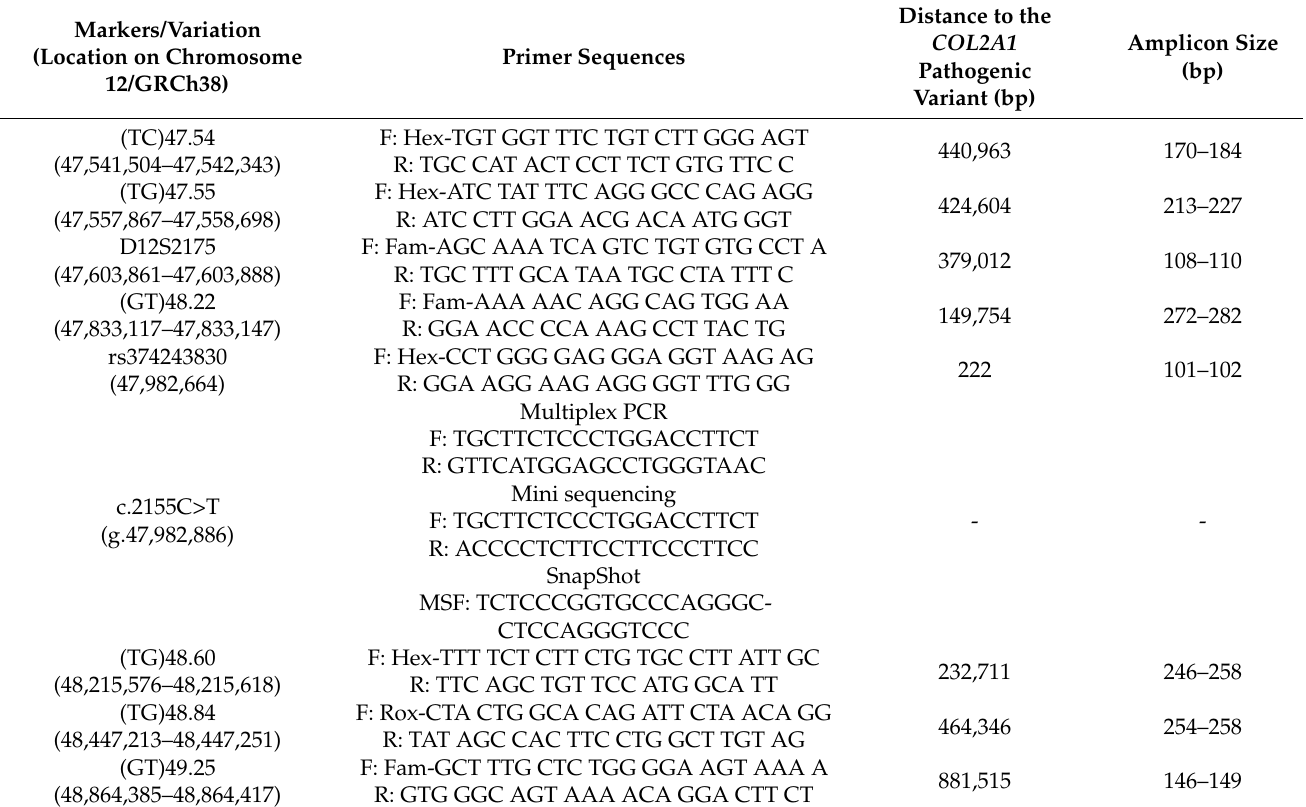
Table 2. Sequences studied during the PGT-M cycle (location, sequences of the primers and distance to the pathogenic